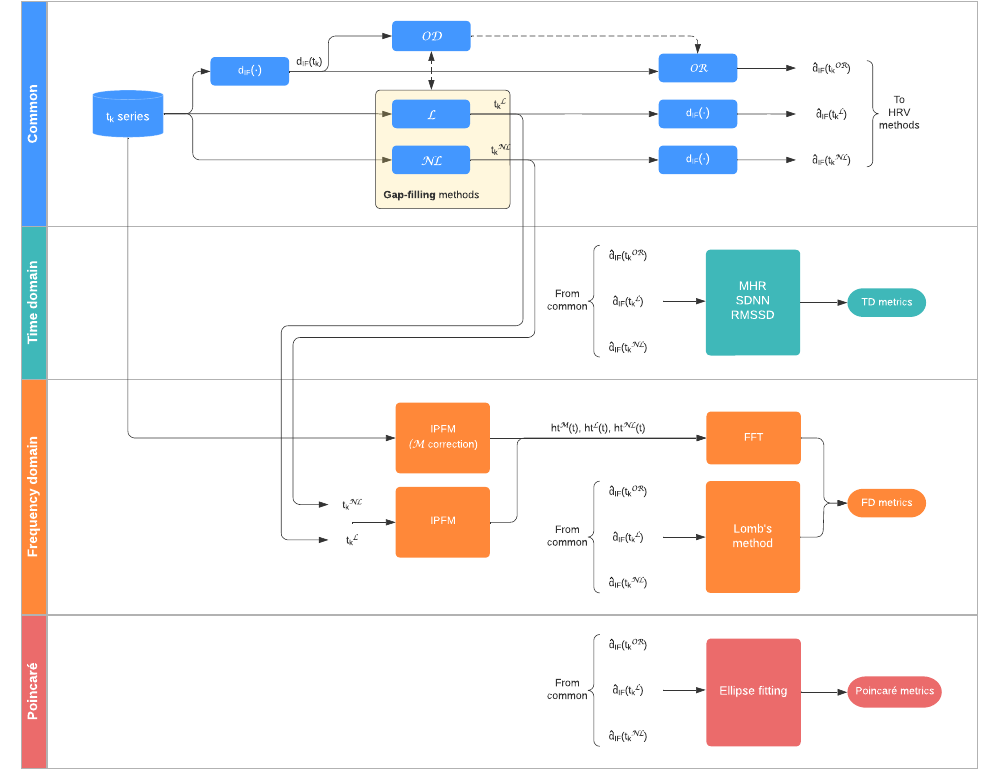
Figure 2. Process flow. OD = Outlier Detection; OR = Outlier Rejection; L = Linear; N L = Non- Linear; M =